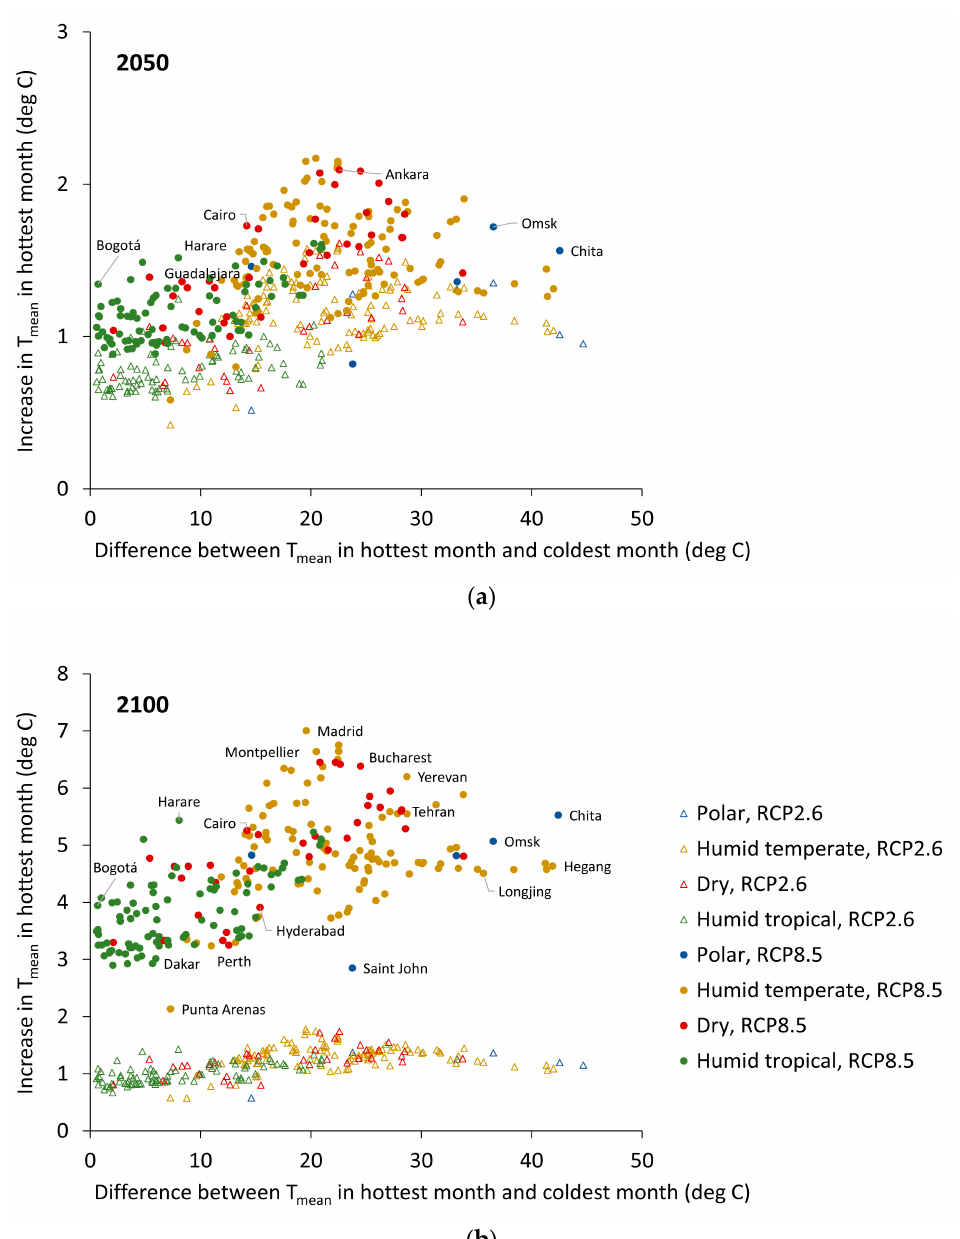
Figure 5. Increases in T mean for the hottest month relative to 2017: relationship to the seasonal variation in temperature as represented by the difference between the T mean for the hottest and coldest month by ( a ) the year 2050 and ( b ) the year 2100. Colouring indicates Bailey’s ecoregion domain.